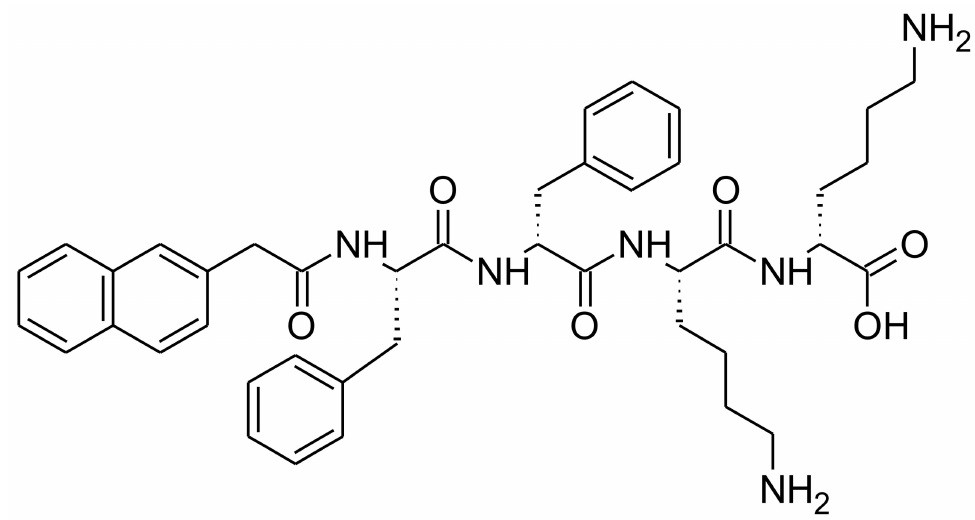
Figure 1. Chemical structure of NapFFKK-OH hydrogelator.